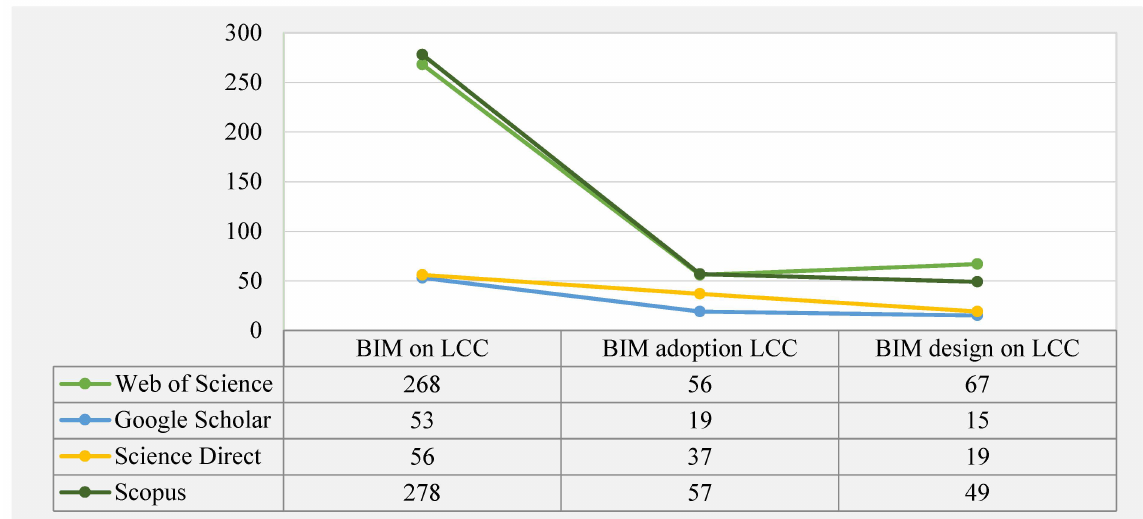
Figure 2. Screening and classification of the